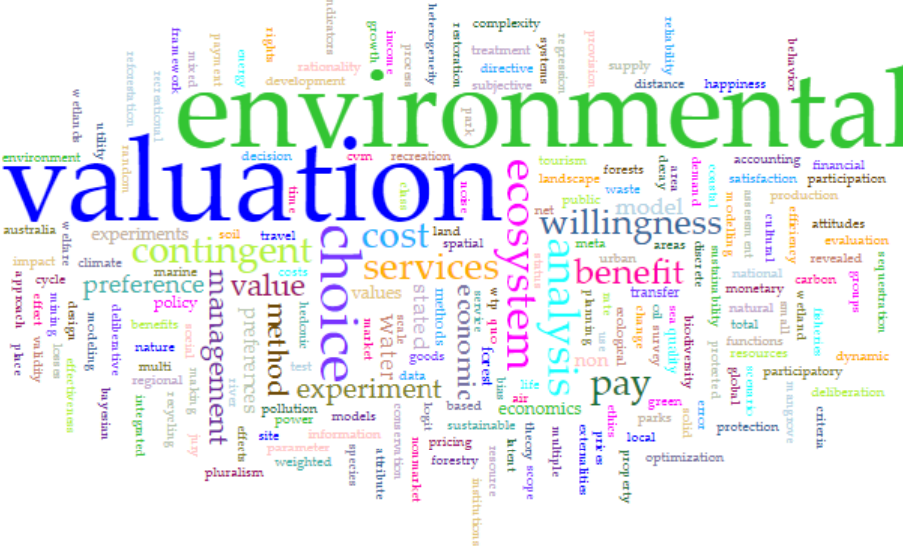
Figure 10. The word cloud of the author keywords related to environmental valuation using Voyant Tools.